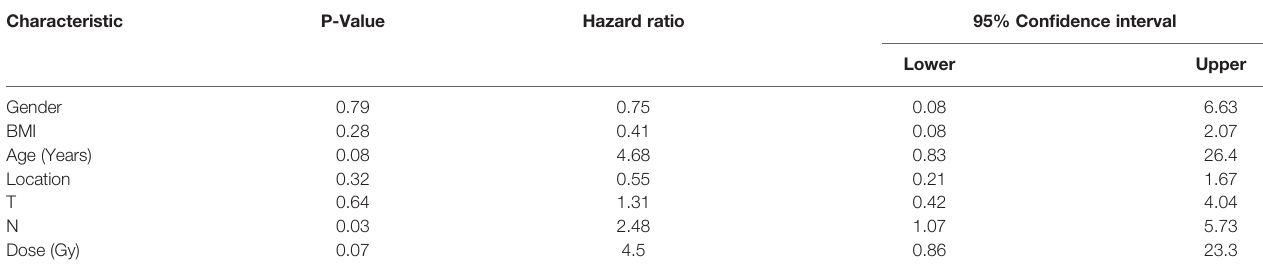
TABLE 4 | Logistic regression analysis of the relationships between effectiveness of chemoradiotherapy (CRT) and serum levels of CYFRA21-1 and NSE.